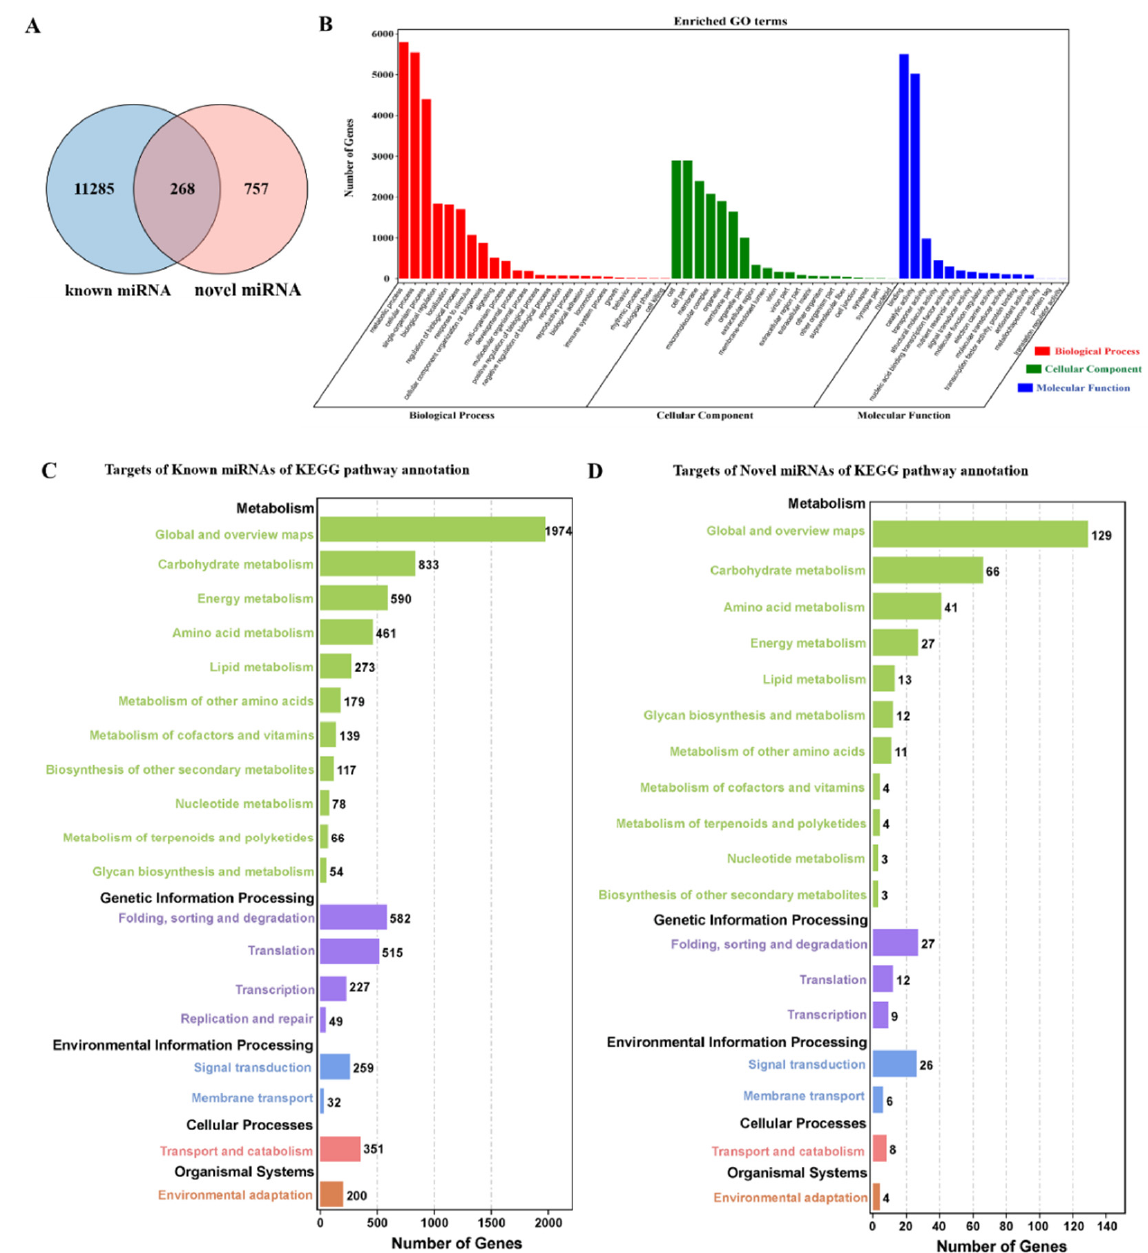
Figure 4. Target prediction of miRNAs and function enrichment analysis. ( A ) Venn diagram showing target prediction of known miRNAs and novel miRNAs. ( B ) Gene ontology (GO) enrichment analysis of the biological functions of targets. Genes were assigned into three main categories: biological processes, cellular components and molecular functions. The y-axis indicates the number of genes in a given category. ( C ) Histogram of cluster of KEGG pathways of known miRNA targets. The results were summarized in five main categories (black words). ( D ) Histogram of cluster of KEGG pathways of novel miRNA targets. The results were summarized in five main categories (black